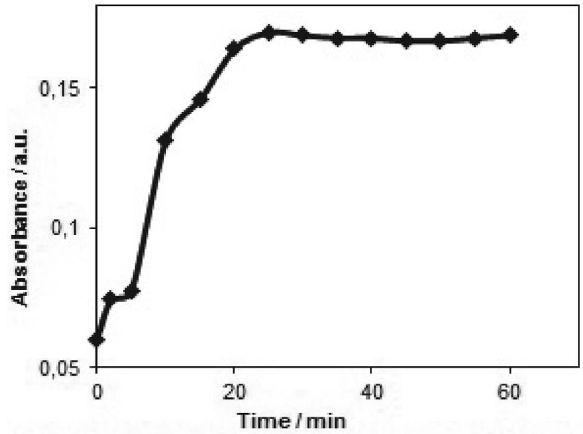
Fig 6. Effect of heating time on the maximum yield of Ru(IV) with HITO colored complex.